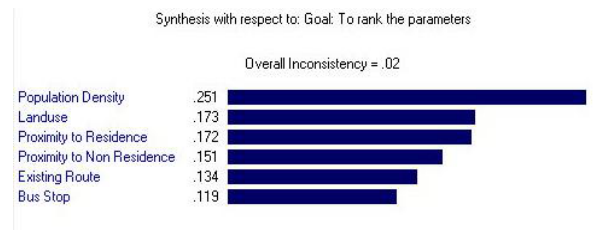
Figure 3 Consistency value of Pairwise Comparison c) Weighted Overlay